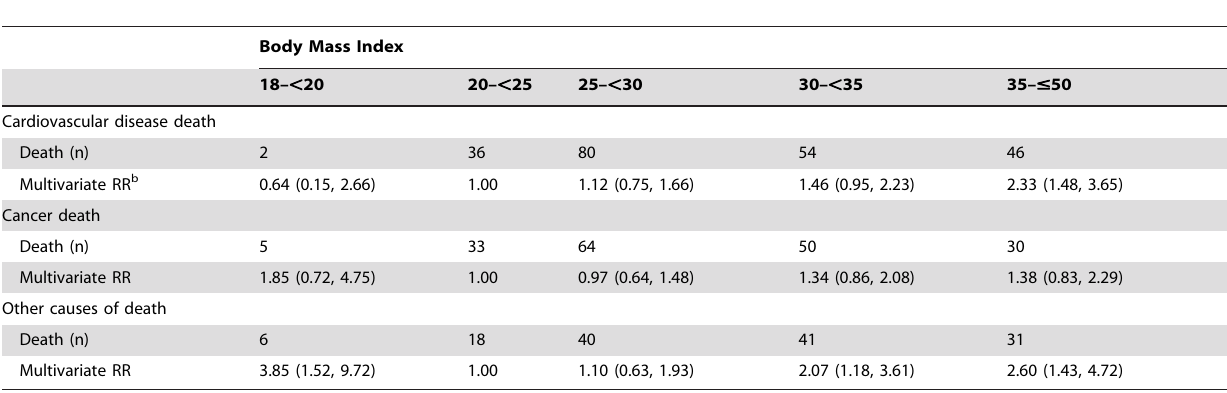
Table 3. Relative risks (RR) and 95% confidence intervals for cause-specific deaths in non-Hispanic black never smokers a .